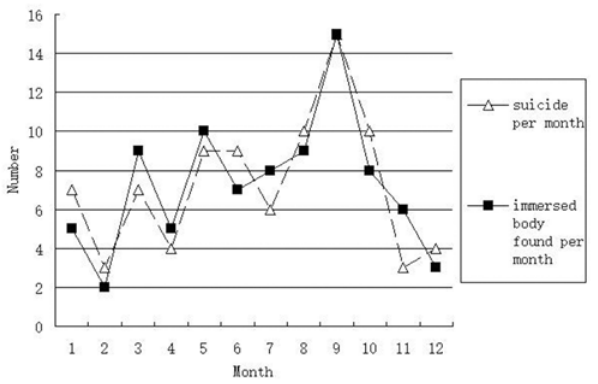
Fig 1. Number of suicide per month and immersed body found per